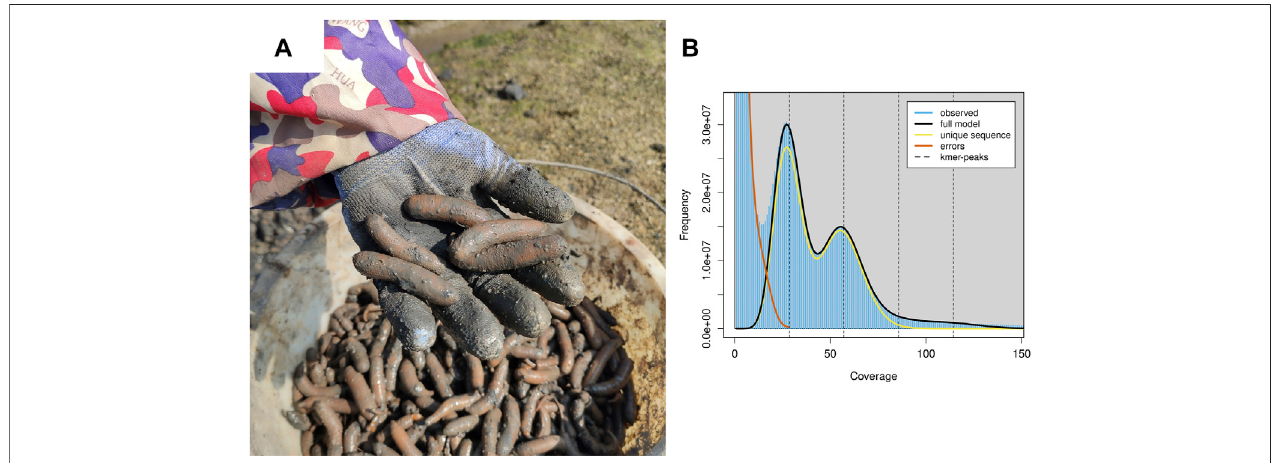
FIGURE 1 | Harvest P. esculenta and the genomics feature of P. esculenta . (A) Harvest P. esculenta from local aquaculture farms. (B) A K-mer analysis of the genome sequencing reads for the P. esculenta using GenomeScope